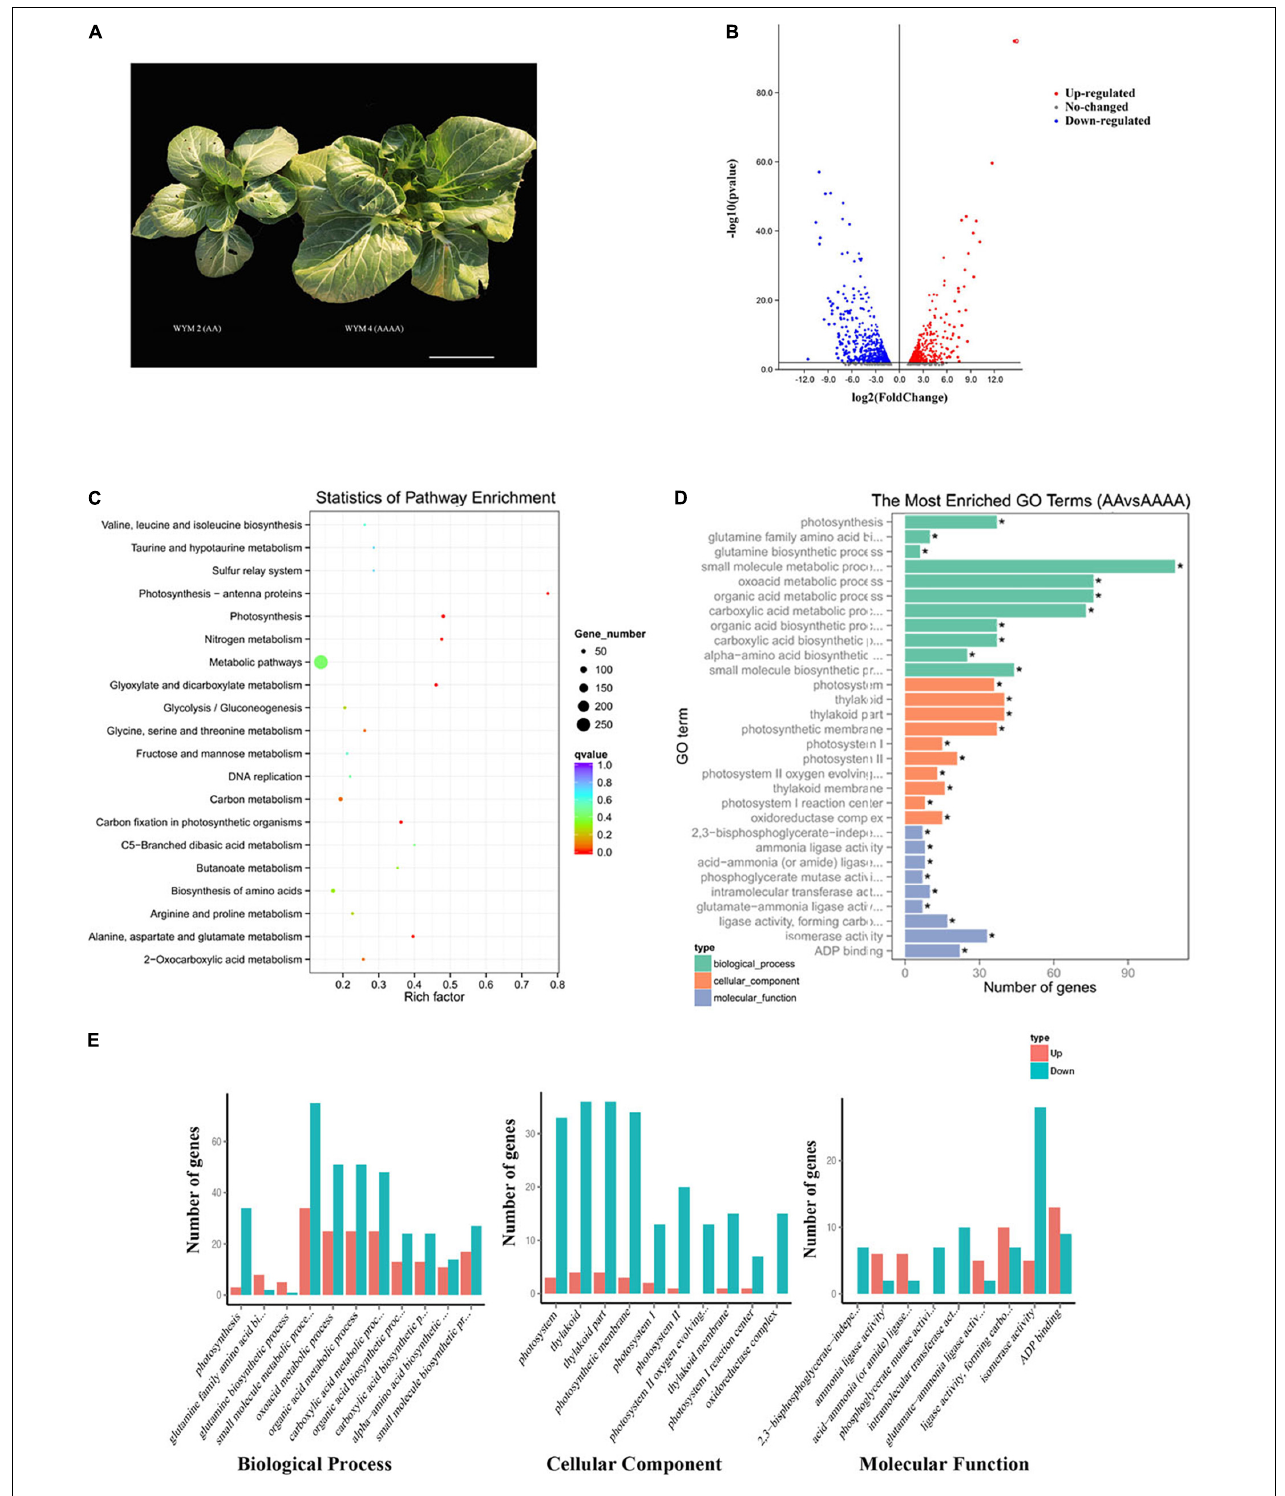
FIGURE 1 | RNA-seq analysis of diploid (AA) and autotetraploid (AAAA) pak choi. (A) Phenotypic differences. Scale bar = 10 cm. (B) Volcano map of DEGs. Red points denote up-regulated genes; blue points denote down-regulated genes; gray points denote non-differentiated genes. (C) The top 20 enriched KEGG pathways of DEGs. The pathway label is on the vertical axis, the Rich factor is on the horizontal axis, the size of the dots represents the number of DEGs in the pathway, and the color of the dots represents the distinct Q -value levels. (D) The most enriched GO terms with all DEGs. The ordinate is the enriched GO term, the abscissa is the number of DEGs in the term, and GO terms with “*” are significantly enriched. (E) The most enriched GO terms with up-regulated DEGs and down-regulated DEGs.